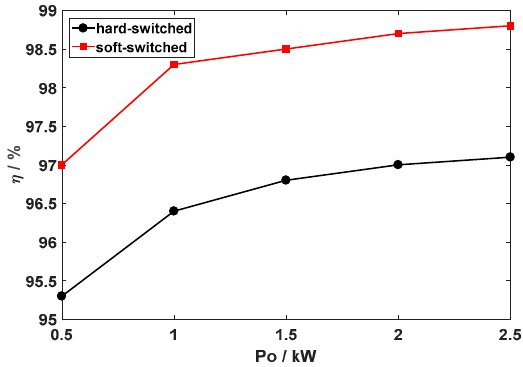
Figure 17. Converter efficiency curve.